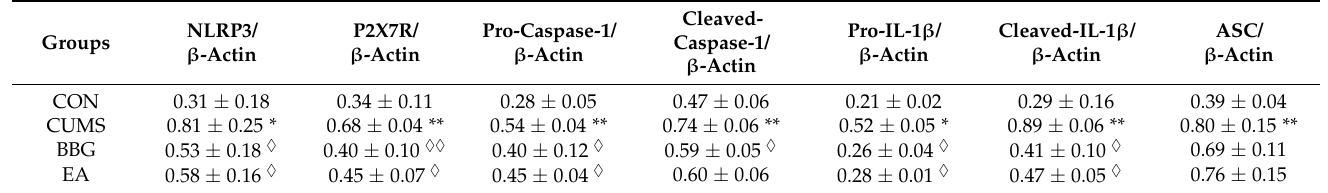
Table 6. Effects of EA on the expression of P2X7R, NLRP3, and IL-1 β related protein in the PFC of CUMS rats.